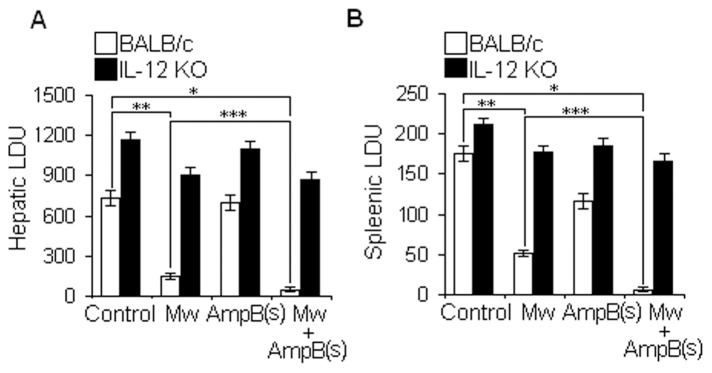
Treatment with Mw or Mw plus AmpB (sub) causes complete clearance of hepatic and splenic parasitic burden of infected BALB/c mice (A–B).BALB/c and IL-12 knockout mice were infected with L. donovani, followed by treatment with either phosphate buffered saline (PBS; control), Mw (108cells/100 µl), suboptimal dose of AmpB (2.1 mg/kg body weight) and Mw plus AmpB (suboptimal). Mice were sacrificed on day, 56 after infection. Untreated, infected mice were used as controls. Levels of parasitic burden in liver (A) and spleen (B) samples were expressed in Leishman Donovan Units (LDU). Data were expressed as mean ± SD (n = 4 mice per group) *P<0.001, **P<0.01 compared with infected mice and ***P<0.05 compared with Mw treated infected mice; paired two-tailed Student’s t-test.